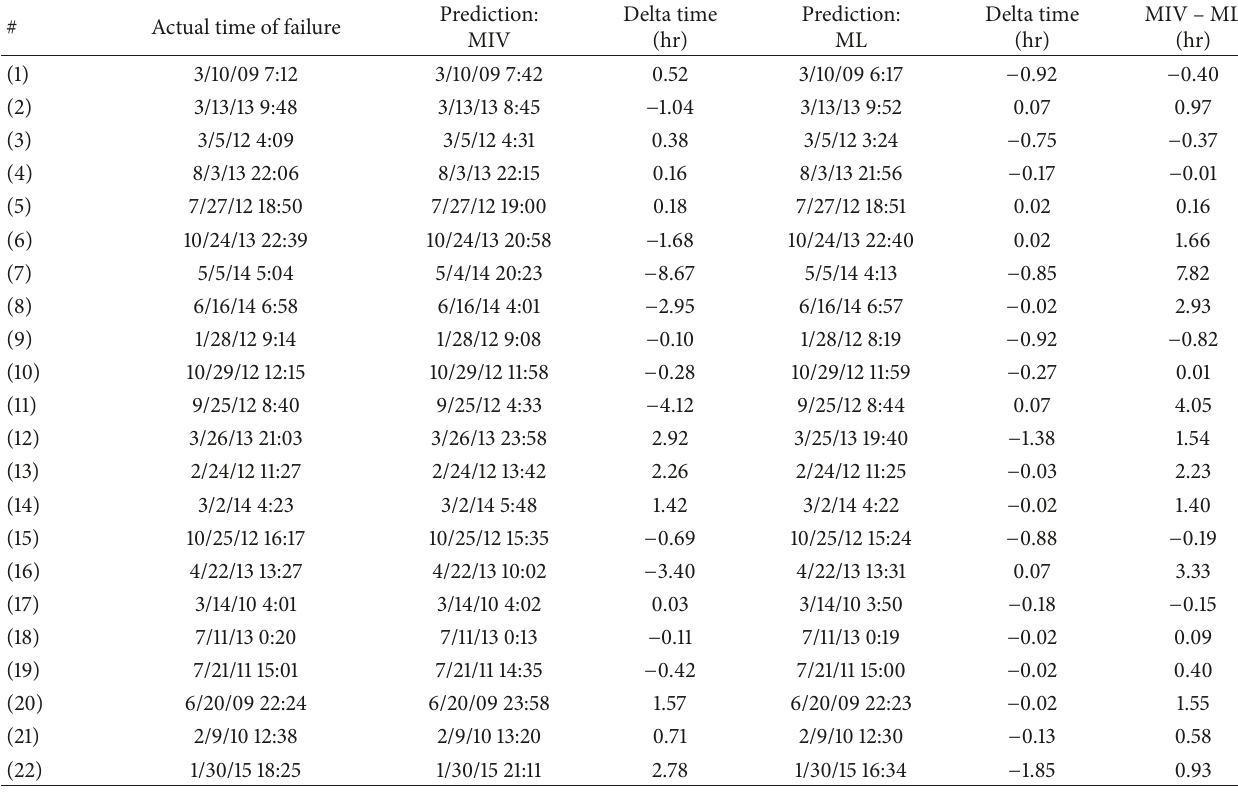
Table 3: Results of the comparison between minimum inverse velocity (MIV) and machine learning (ML) method from 22 different failure examples.